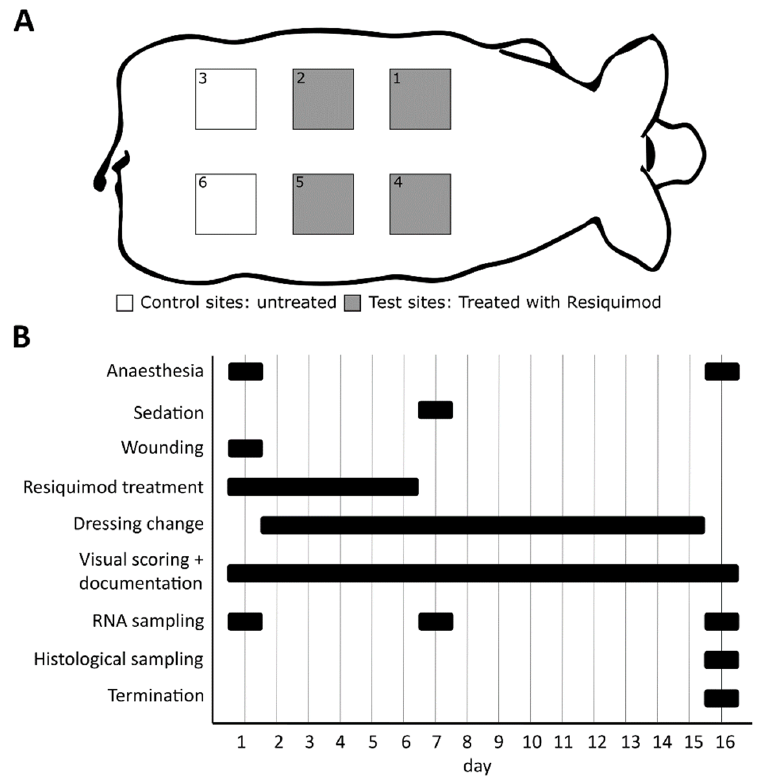
Figure 1. Schematic presentation of the experiment setup. ( A ) Each pig (n = 10) received 6 wounds on its back, 4 of which were treated with resiquimod, and 2 of which remained untreated as control wounds. Control and resiquimod-induced wounds were randomly arranged on the back of each pig to avoid a location bias. ( B ) The entire duration of the experiment was 16 days, during which the animals were anesthetised twice and received a sedation once. Resiquimod application lasted for 6 days. Dressing changes were performed on a daily basis, as were visual scoring and documentation. Biopsies for gene expression analysis were collected on days 1, 7 and 16, and biopsies for histology were collected only on day